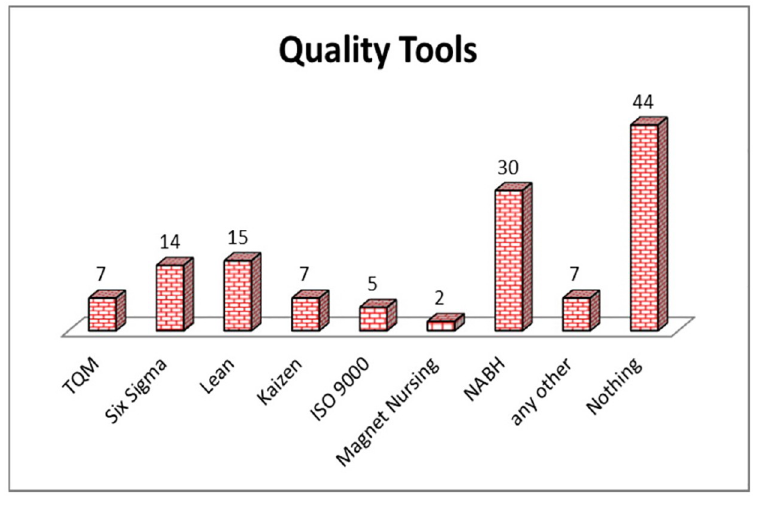
Fig 1. Implementation of various quality tools in different hospitals.